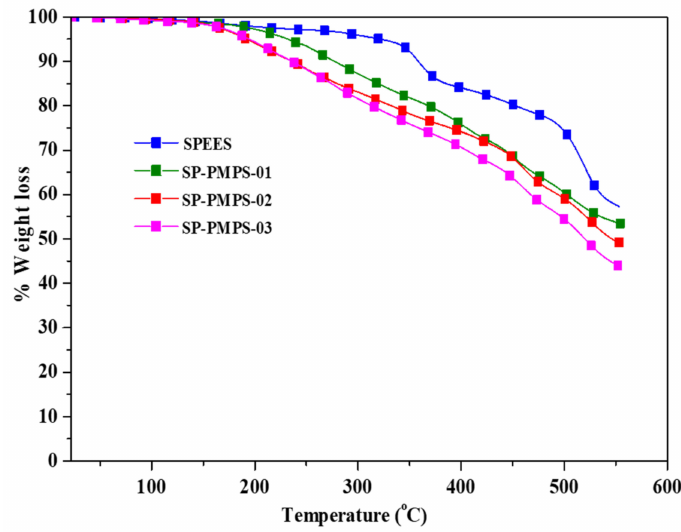
Figure 3. Thermogravimetric analysis (TGA) graph of prepared SP-PMPS